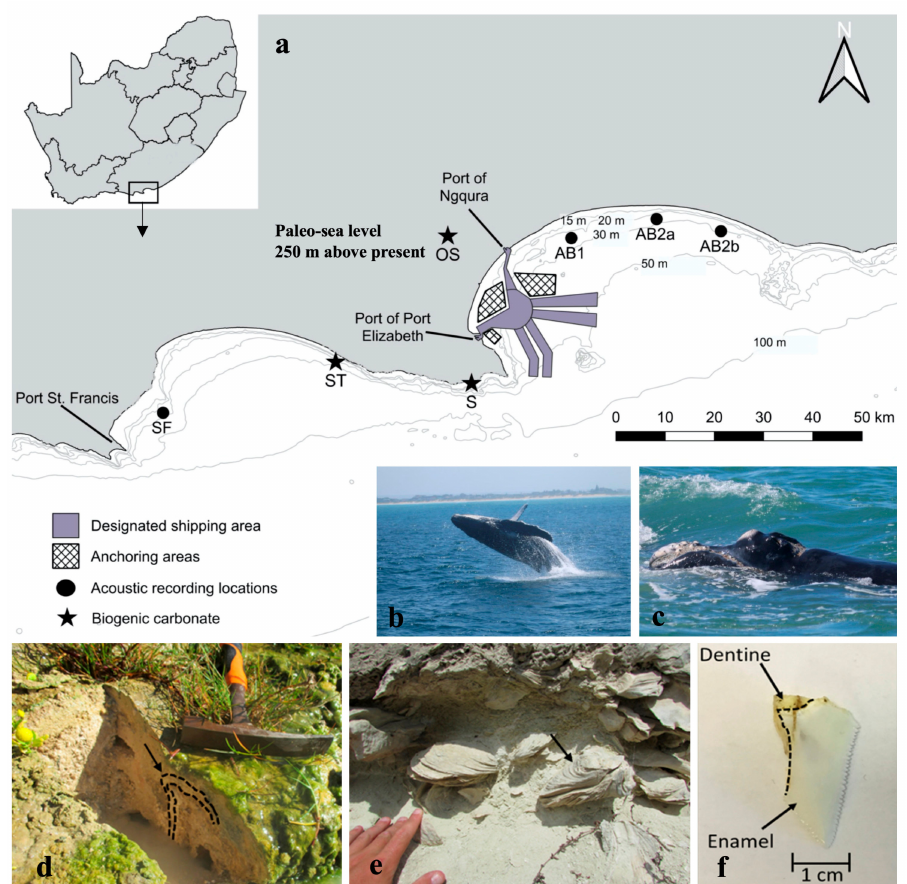
Figure 5. Soundscape ecology and geochemical studies of St. Francis and Algoa Bay, near Port Elizabeth: ( a ) Map showing the location of acoustic loggers and biogenic carbonate samples; ( b ) humpback whale ( Megaptera novaeangliae ) calf; ( c ) southern right whale ( Eubalaena australis ) calf; ( d ) stromatolites (site S); ( e ) Plio-Pleistocene oyster fossils ( Striostrea margaritacea ; site OS); and ( f ) modern shark teeth ( Carcharodo carcharias ; site